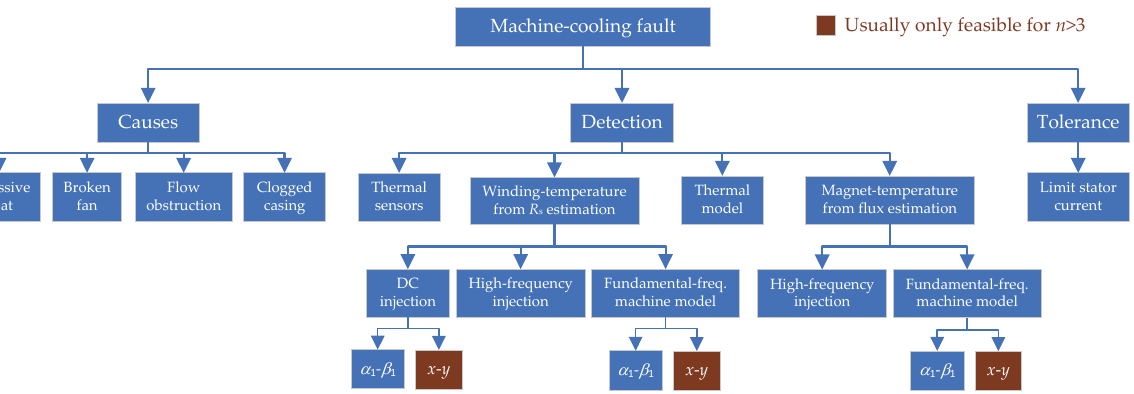
Figure 37. Causes, detection methods, and tolerance approaches for machine-cooling fault in multi- phase